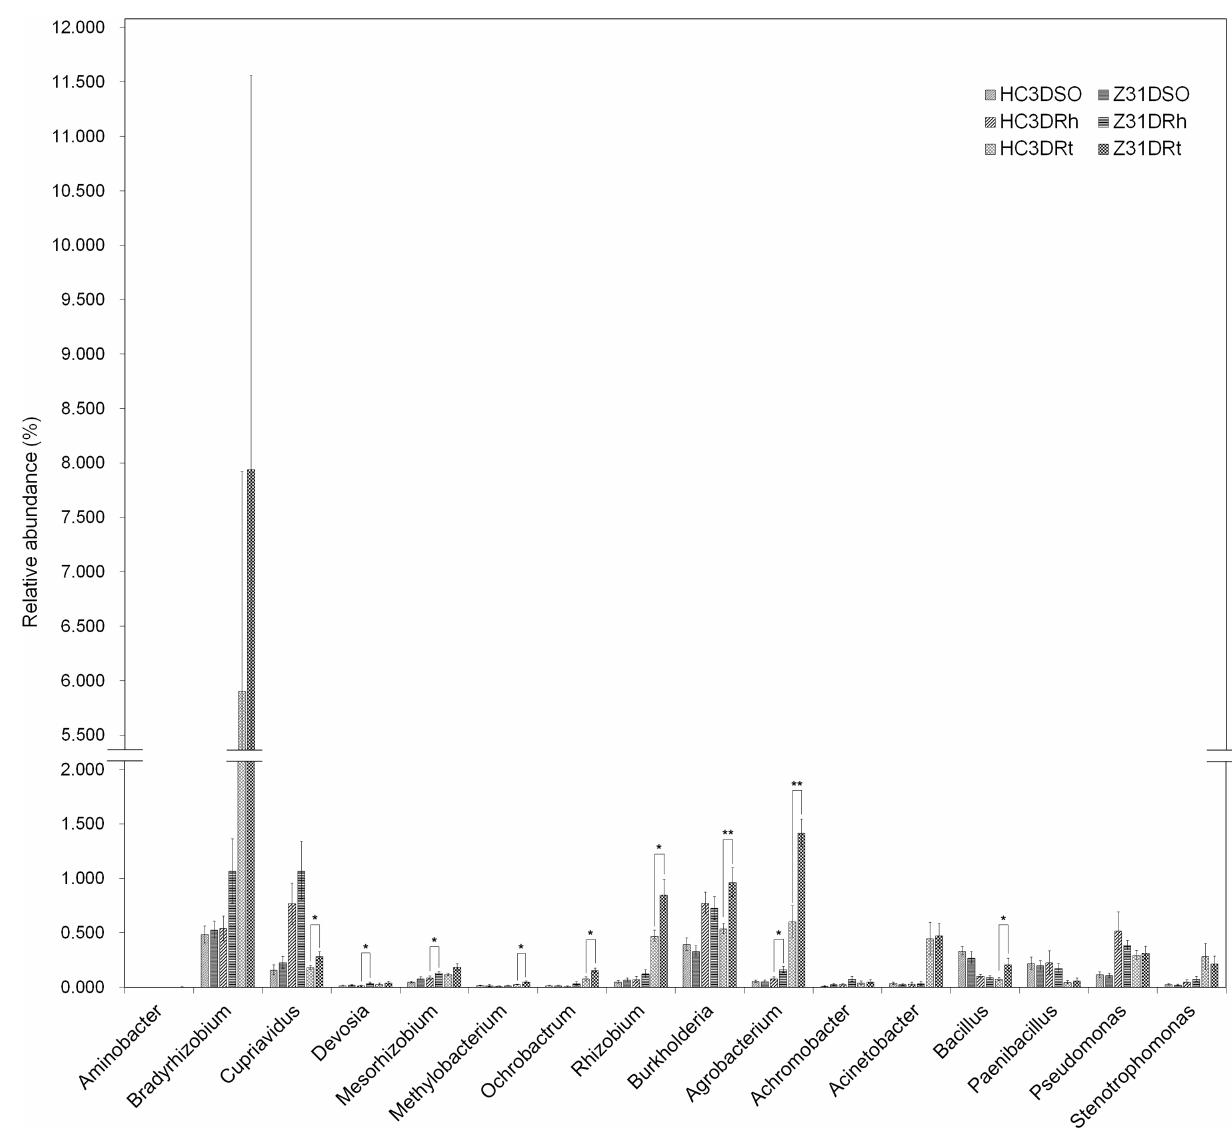
Fig 6. Relative abundances of main nitrogen-fixing bacterial genera at the seed-filling stage. HC3DRt and Z31DRt represent the roots of the recipient cultivar HC3 and the transgenic line Z31 at the seed-filling stage, respectively. HC3DRh and Z31DRh represent the rhizospheric soils of the recipient cultivar HC3 and the transgenic line Z31 at the seed-filling stage, respectively. HC3DSO and Z31DSO represent the surrounding soils of the recipient cultivar HC3 and the transgenic line Z31 at the seed-filling stage, respectively. Error bars indicate SE calculated by Metastats. Values are mean ± SE (n = 6); (cid:3) , P < 0.05; (cid:3)(cid:3) , P < 0.01.